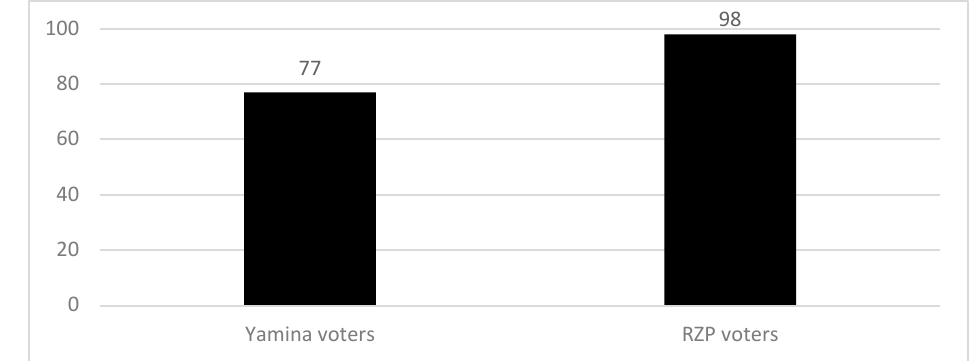
Figure 22. The Supreme Court judges act upon their political beliefs (by voting in 2021, %).